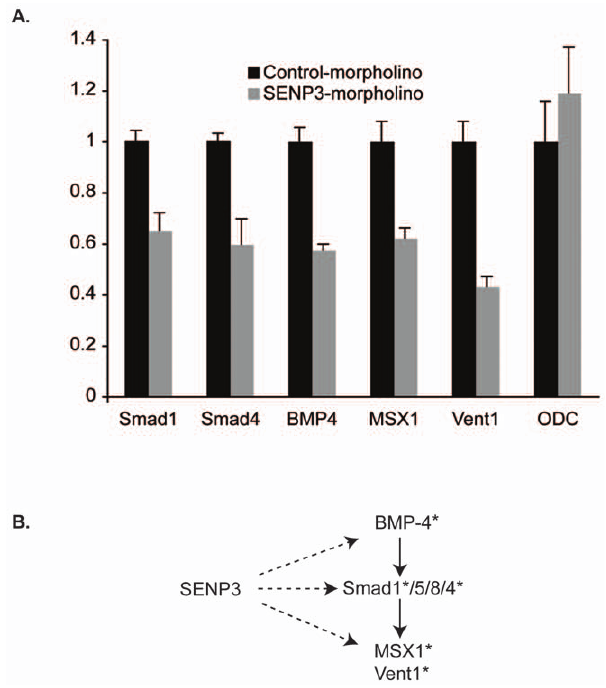
Figure 5. Inhibition of TGF-Beta signalling by SENP3 knock- down. ( A ) One cell embryos were injected with morpholinos, and harvested at Stage 39. The cDNA was generated from total RNA of tadpoles. The levels of expression for the indicated mRNAs were evaluated for Control-MO or SENP3-MO populations by qRT-PCR, and normalized to that of the control gene, elongation factor-1 a , and the mean of the Control-MO was set to 1. One non-regulated gene, ornithine decarboxylase (ODC), was analyzed by qRT-PCR to confirm equivalent inputs of total mRNA. For individual genes, three independent samples were analyzed, and all comparisons had p values of , 0.05. ( B ) Schematic representation of BMP signalling. SENP3 depletion disrupts expression of BMP target genes, MSX1 and Vent1. Asterisks indicate genes that are downregulated in the absence of